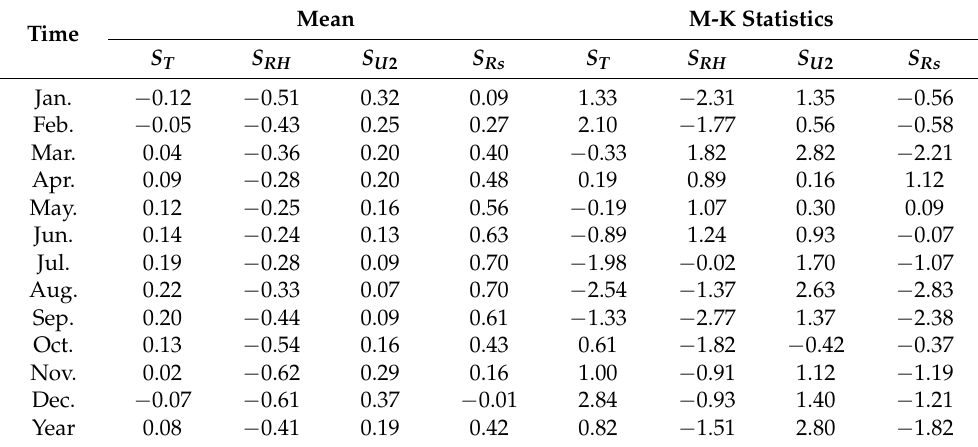
Figure 3. Characteristics of average daily sensitivity coefficient of ET 0 to meteorological factors. Table 2. Temporal characteristics of sensitivity coefficient of ET 0 to meteorological factors.